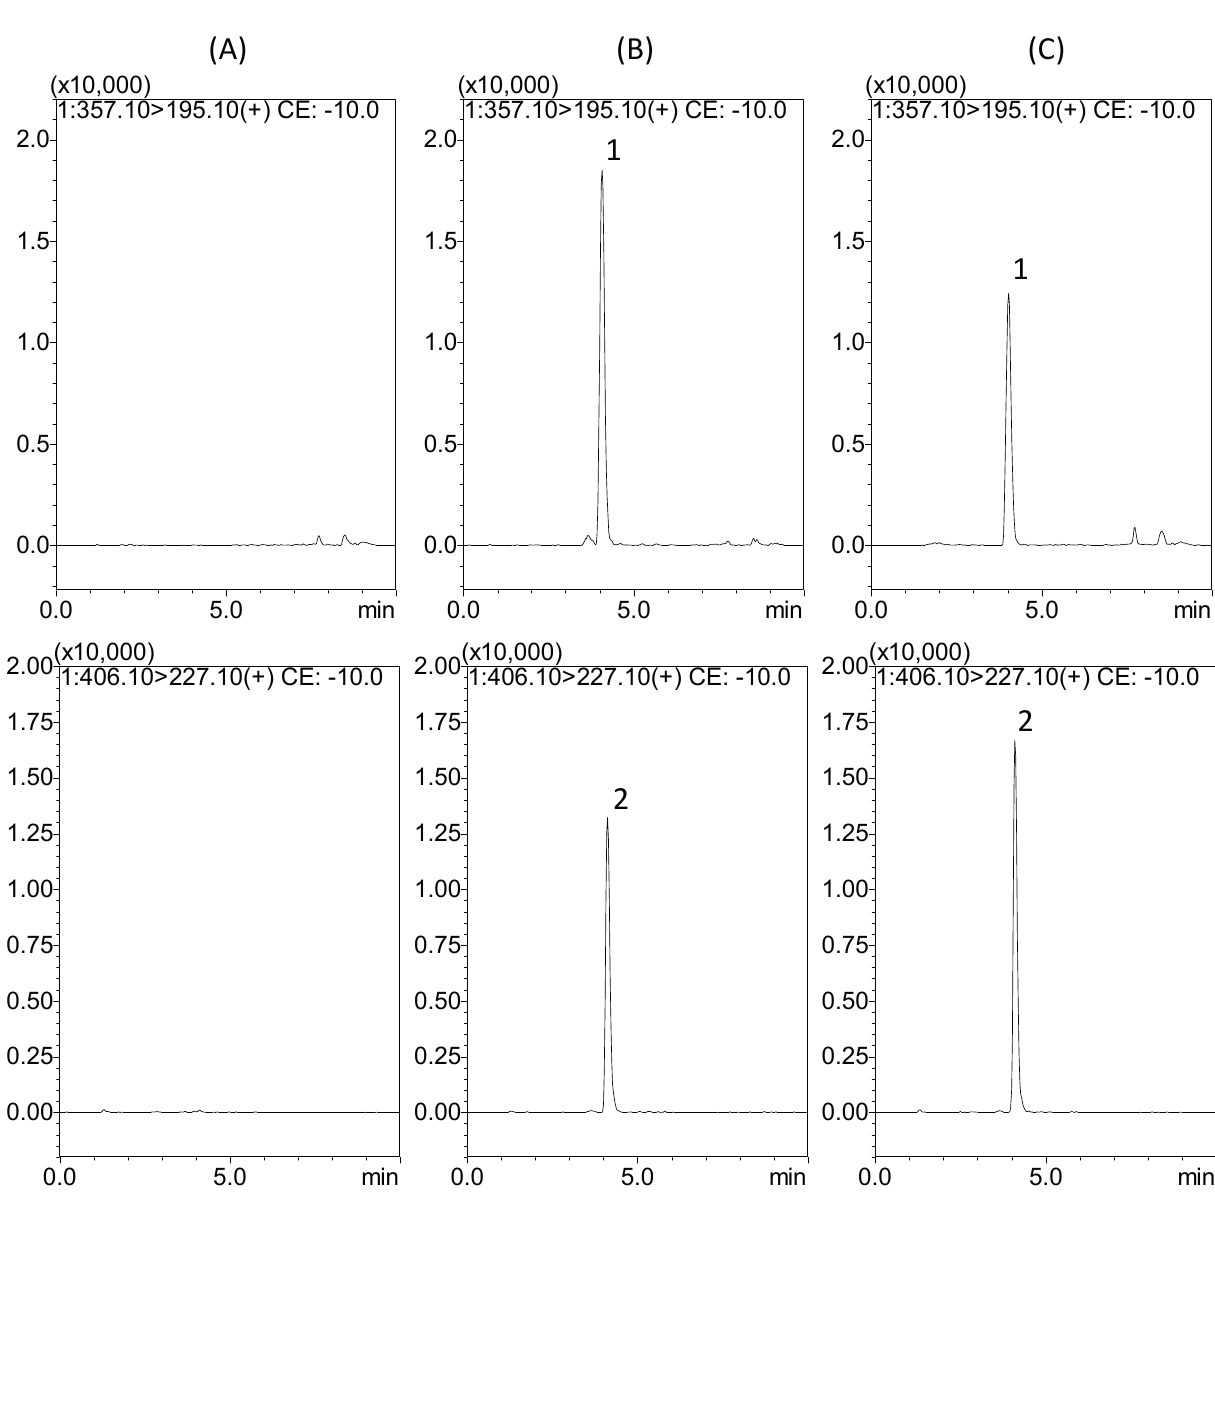
Figure 2. Representative MRM chromatograms of gentiopicroside (channel 1), geniposide (channel 2), baicalin (channel 3), swertiamarin (channel 4), and carvedilol (IS) (channel 5) in rat plasma: ( A ) blank plasma samples; ( B ) blank plasma samples spiked with gentiopicroside, geniposide, baicalin, swertiamarin, and carvedilol (IS) at 500, 50, 100, 25, and 10 ng/mL, respectively; ( C ) diluted plasma sample (×10) of gentiopicroside, geniposide, and baicalin at 240 min, and plasma sample of swertiamarin at 90 min, after oral administration of Long-Dan-Xie-Gan-Tang (10 g/kg,